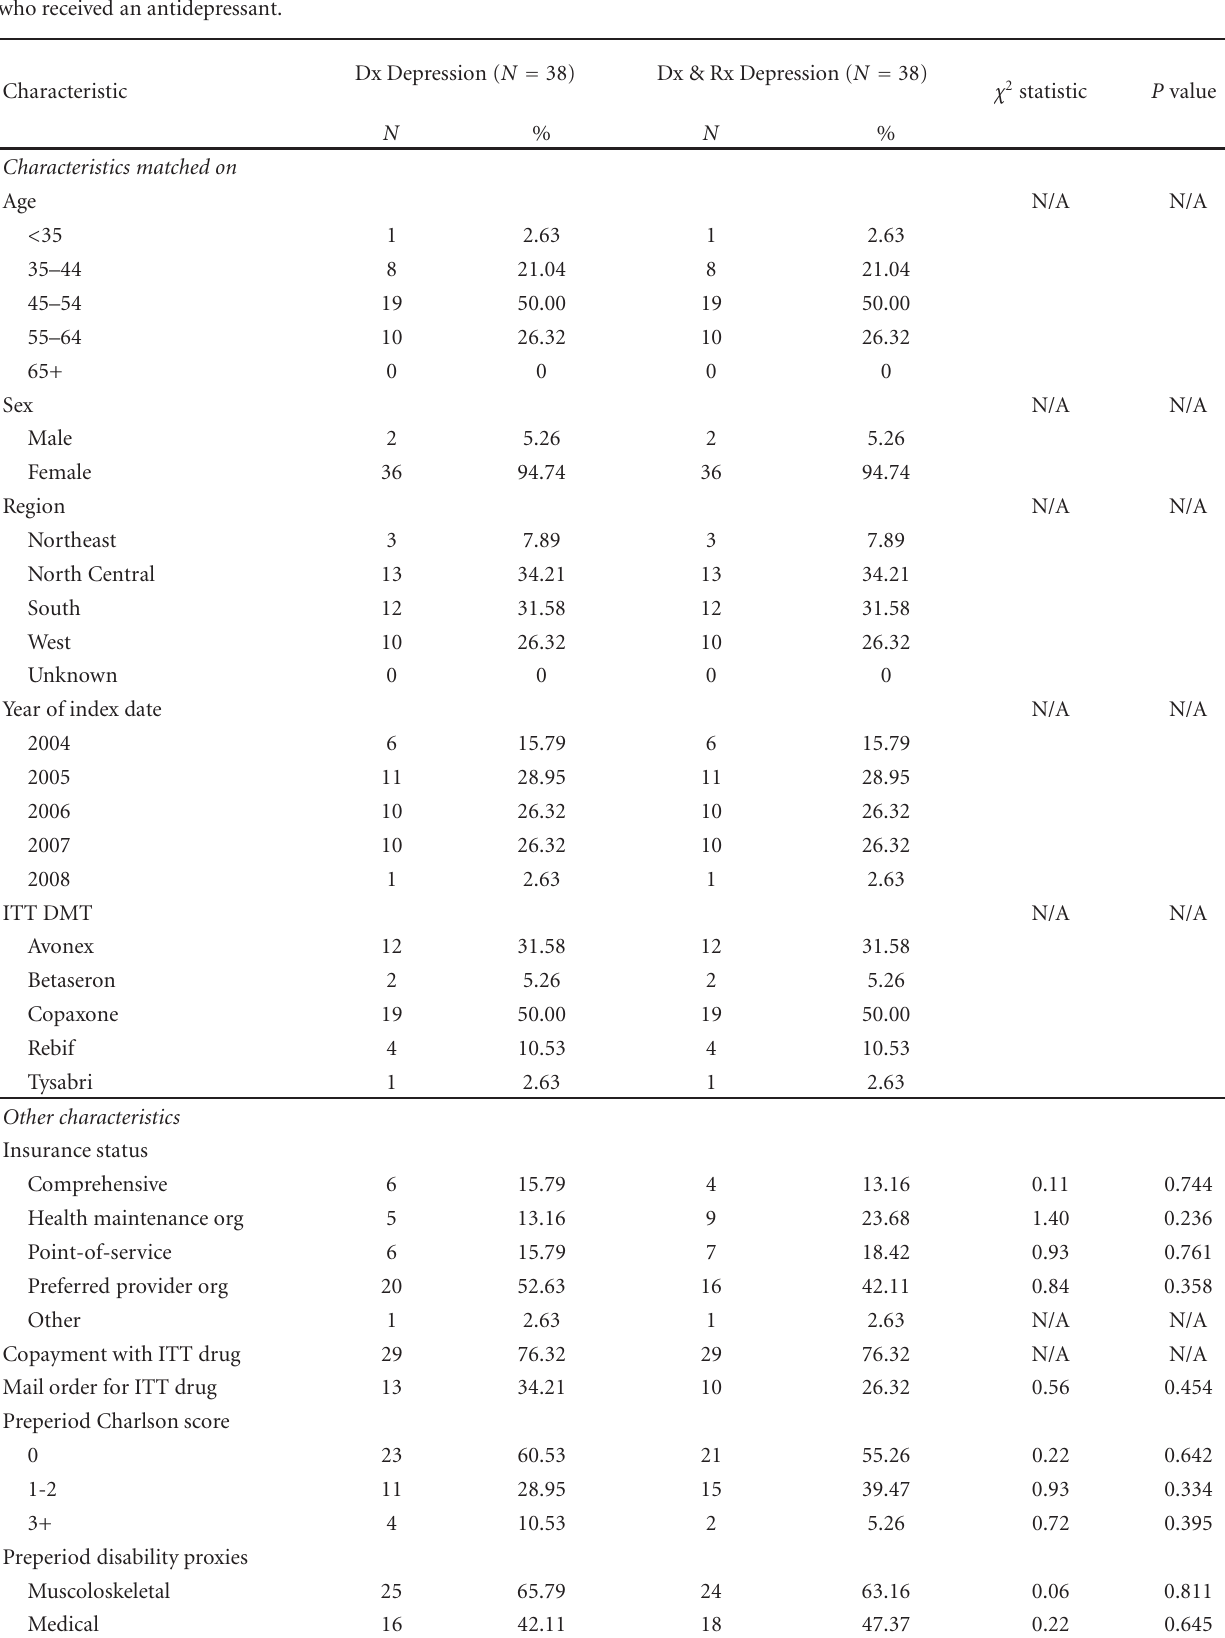
Table 2: Patient characteristics: MS patients diagnosed with depression but untreated compared to MS patients diagnosed with depression who received an